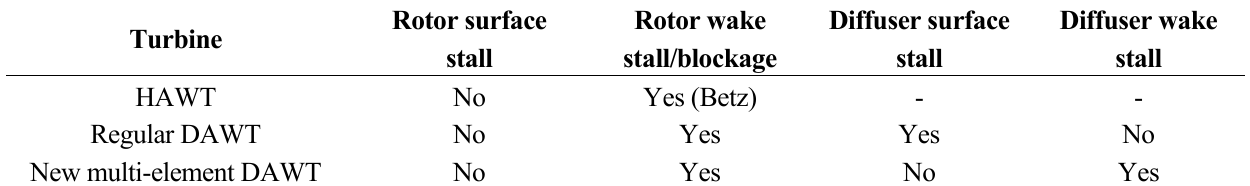
Table 4. Categorization of lift-driven horizontal-axis turbines, and the types of stall (or blockage), which impose an upper limit for energy